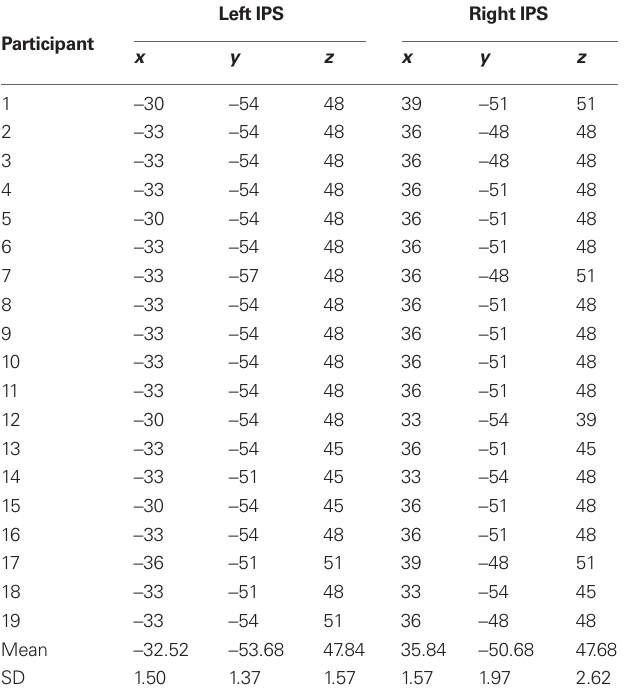
Table 1 | rOi for each participant of the closest activation to the coordinates in the group mean from the conjunction analysis ( x = −33, y = −54, z = 48; x = 36, y = −51, z = 48) used for the dynamic causal modeling